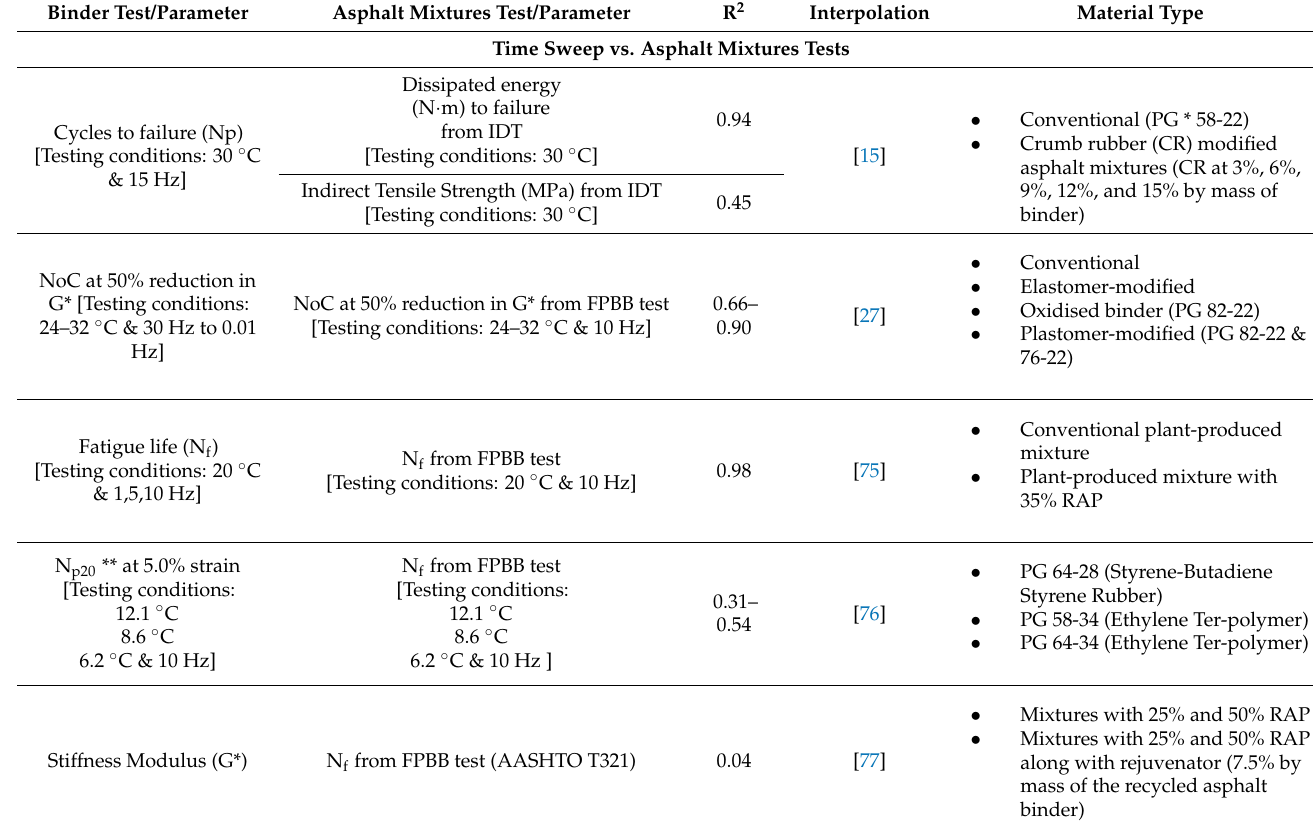
Table 3. Correlations between the properties of the bitumen from time sweep tests and cracking properties of asphalt mixtures from various tests.